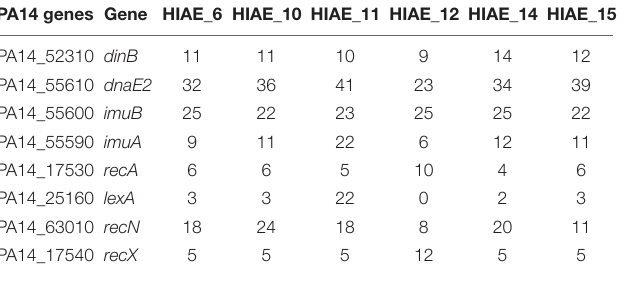
TABLE 3 | Number of SNPs present in adaptive-response related genes of clinical isolates used in this study compared to PA14-UCBPP